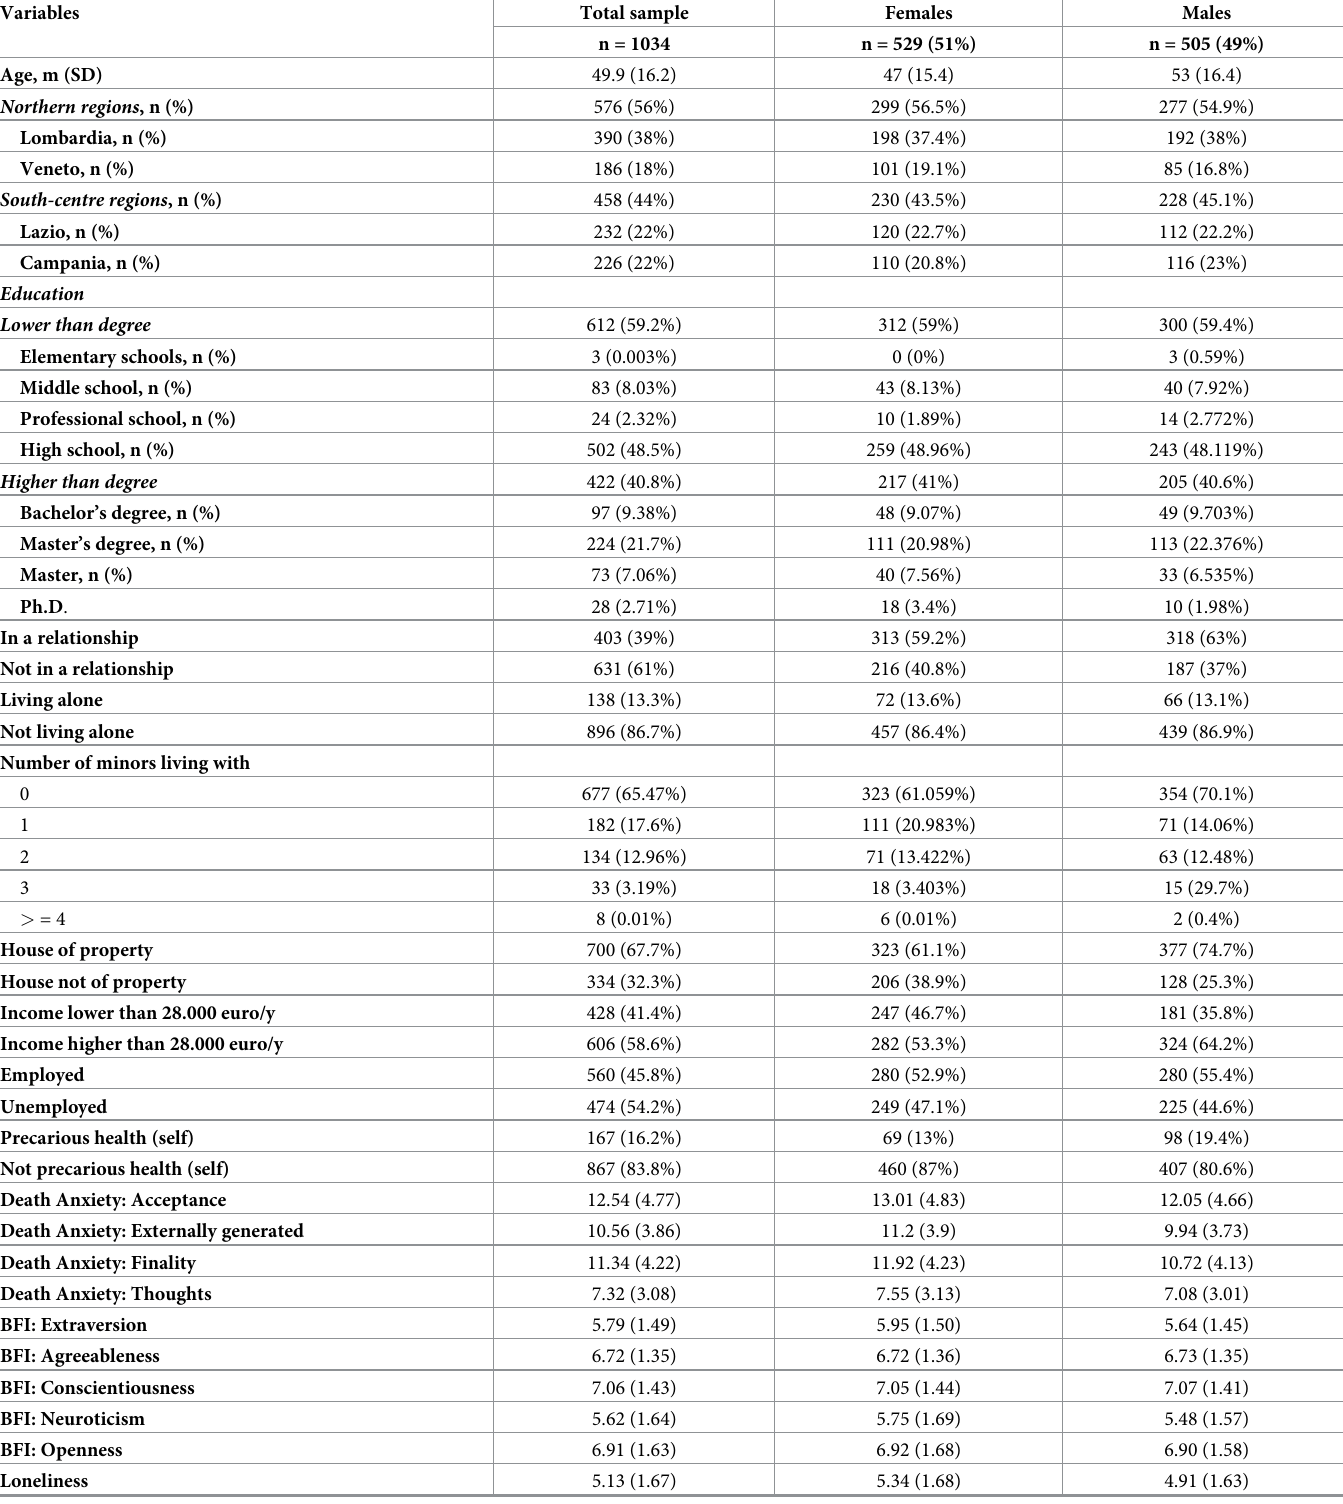
Table 1. Characteristics of the